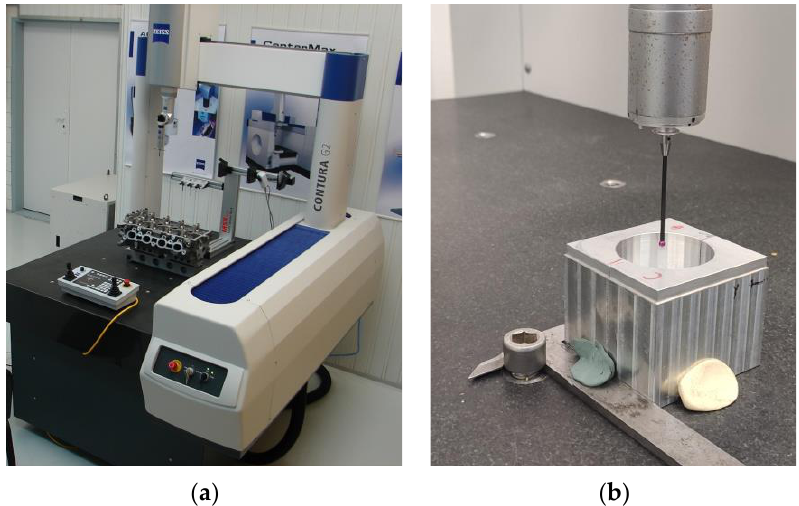
Figure 6. The CMM device Carl Zeiss Contura G2 ( a ) CMM device; ( b ) Clamping and measurement processing.